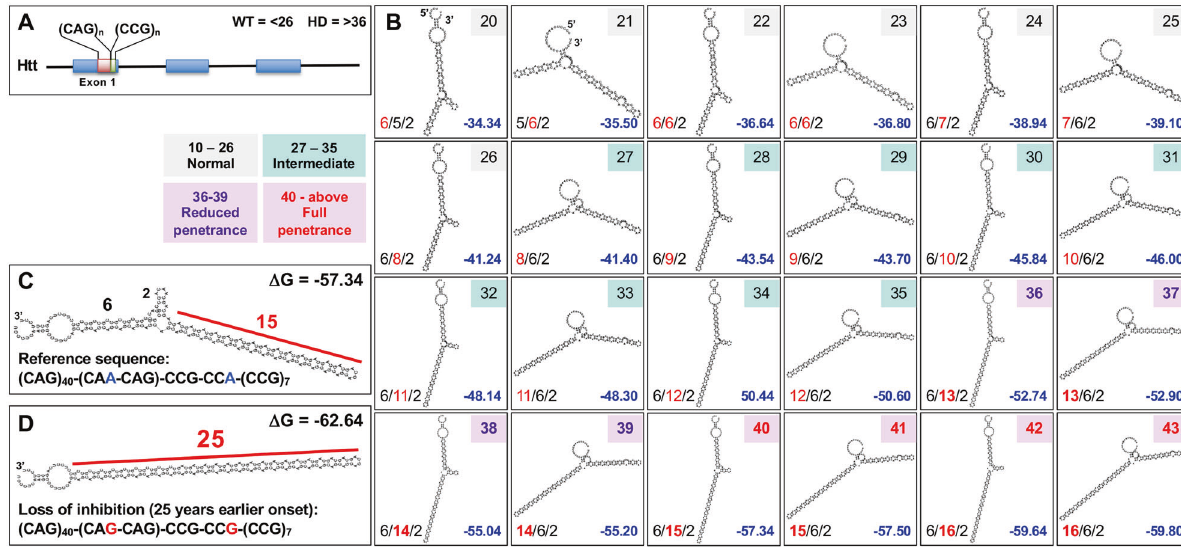
Fig. 2 Folding energies and stem lengths of folded CAG TNRs found in HD patient RNAs correlate with disease severity and/or onset. A Location of the CAG TNR in exon 1 of the HTT gene [71]. B Predicted secondary structure of the section of the HTT mRNAs containing the CAG TNRs (plus 15 nt at either end) at different lengths found in normal, intermediate, reduced, or full penetrance patients. The length of the double stranded CAG TNRs in the stem regions in each HP is given with the longest contiguous one in red. Δ G values (in kcal/mol) are given in blue. C , D Predicted secondary structure of the section of HTT either containing the predominant mutant length of 40 CAG TNRs (the reference sequence) ( C ) or the rare mutant length of 42 CAG TNRs (the loss of inhibition/LOI mutant) ( D ) (plus 15 nts on either side). Secondary structures were predicted using RNAfold. Longest uninterrupted double stranded CAG repeats are labeled with repeat numbers in red. Folding energies are